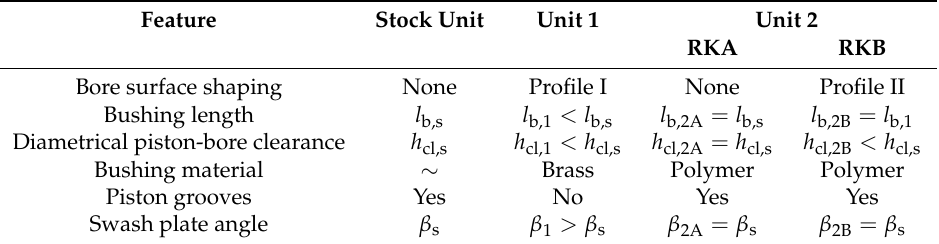
Table 8. Key differences between the stock unit from Table 7, Unit 1, and Unit